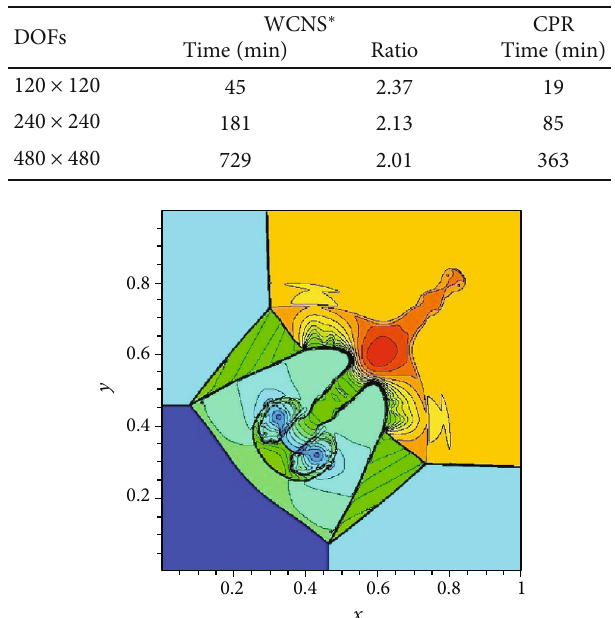
Table 3: The comparison of CPU time in isentropic vortex